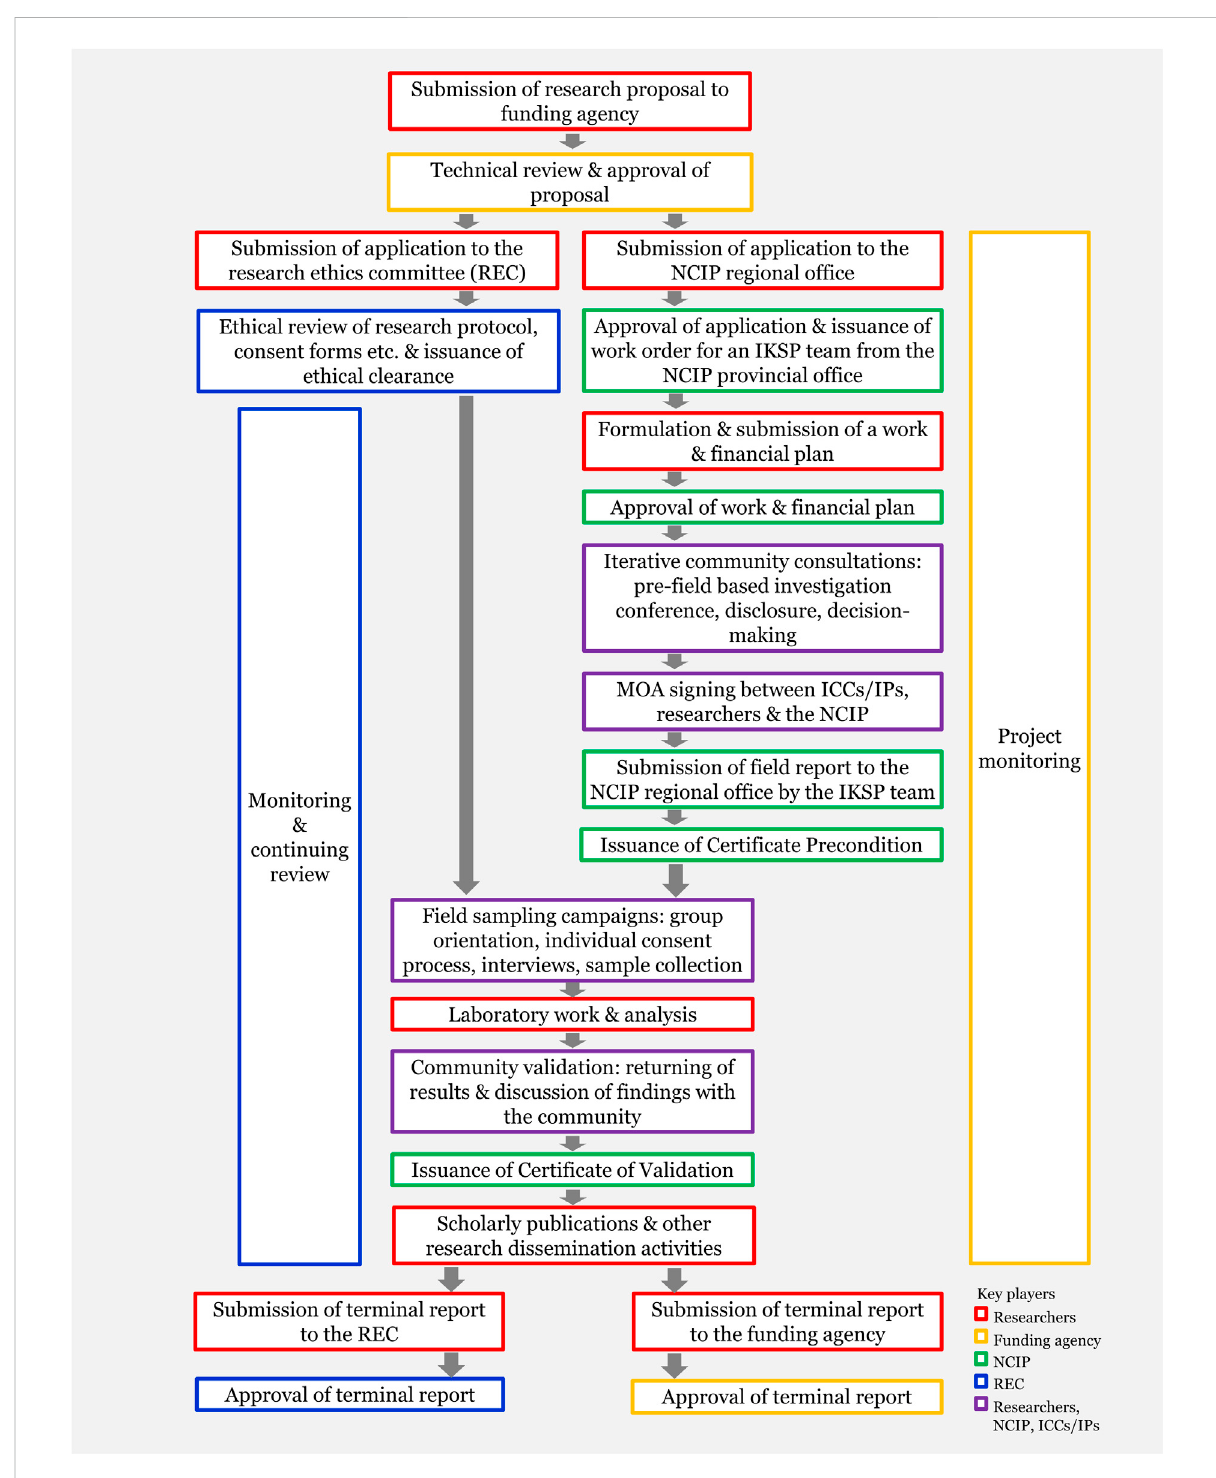
FIGURE 2 Stages of basic academic research among Philippine Indigenous cultural communities/Indigenous peoples